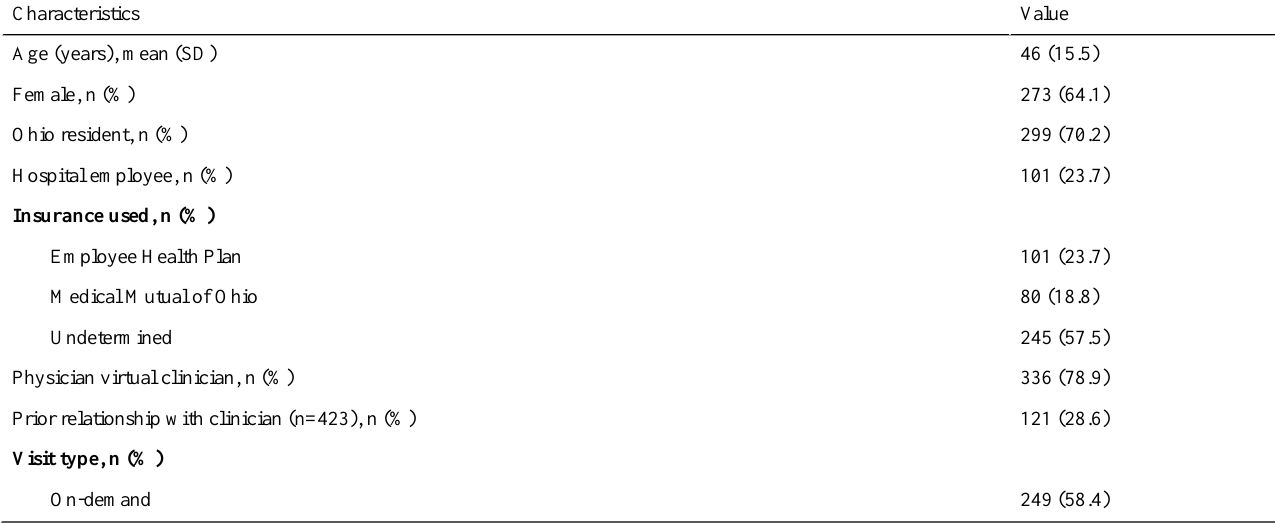
Table 1. Patient and virtual visit characteristics